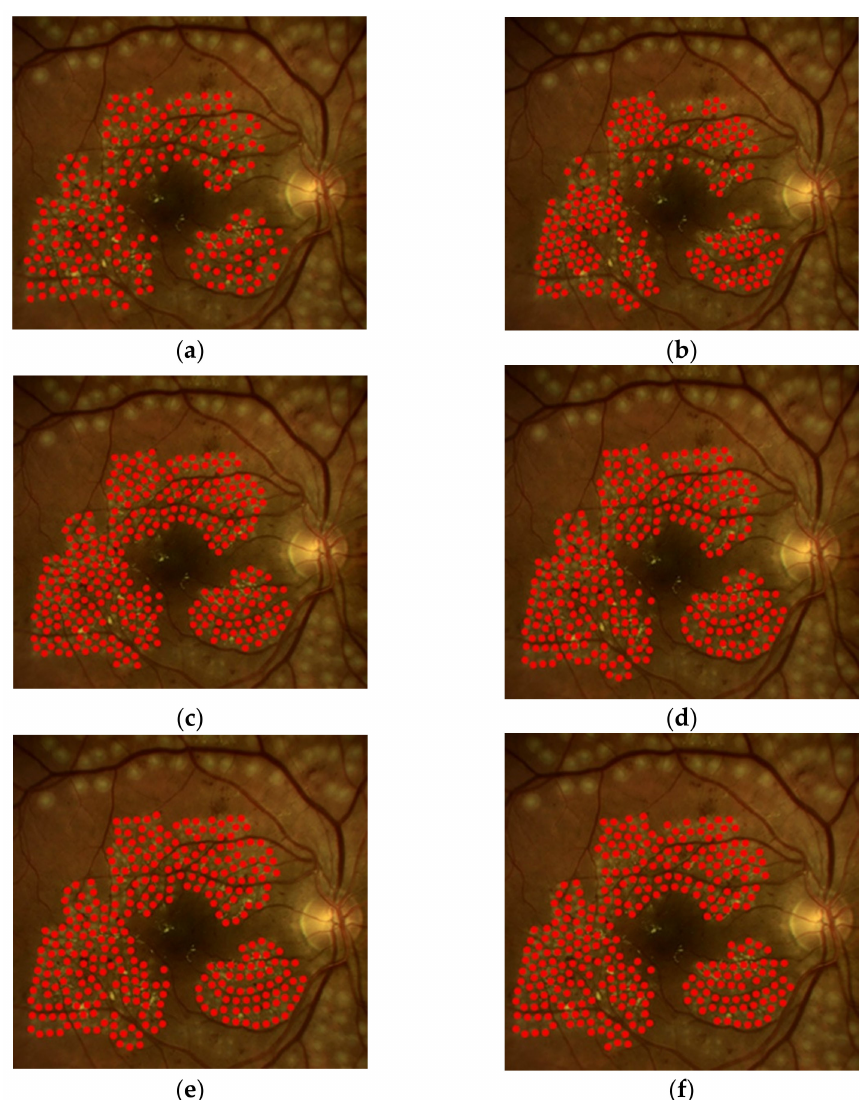
Figure 7. Algorithms for automatic arrangement of coagulates: ( a ) random map; ( b ) square map; ( c ) hexagonal map; ( d ) wave map; ( e ) boundary map; ( f ) adaptive boundary